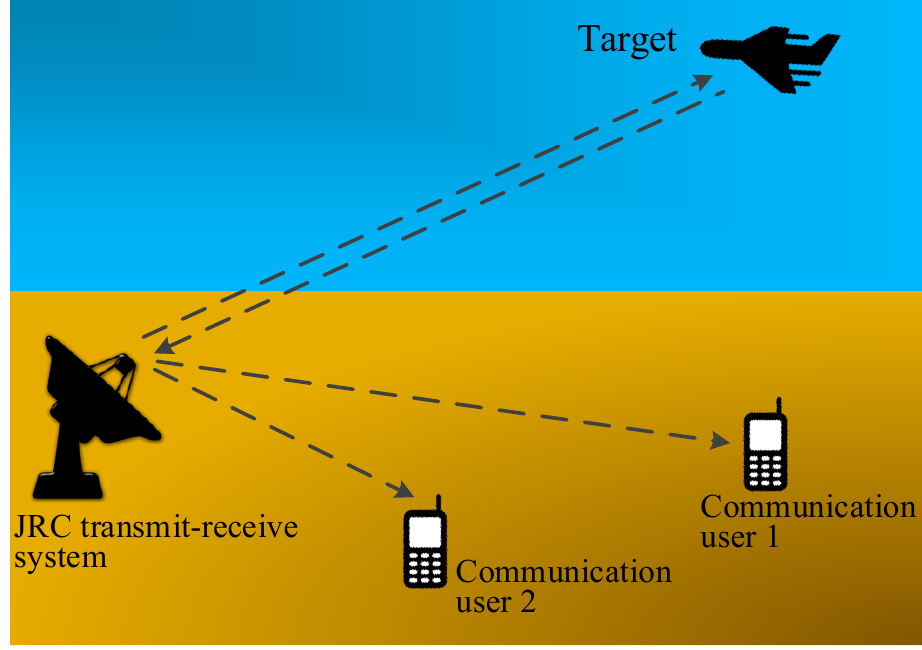
Figure 1. JRC system